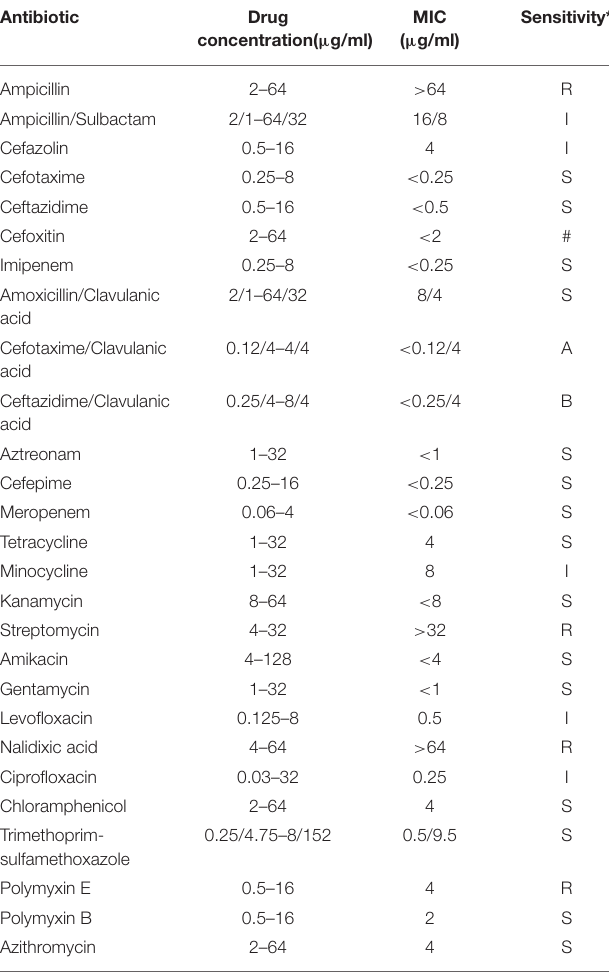
TABLE 2 | Resistotype of the S. Typhi isolate from the patient with typhoid fever. Antibiotic Drug MIC concentration( µ g/ml) ( µ